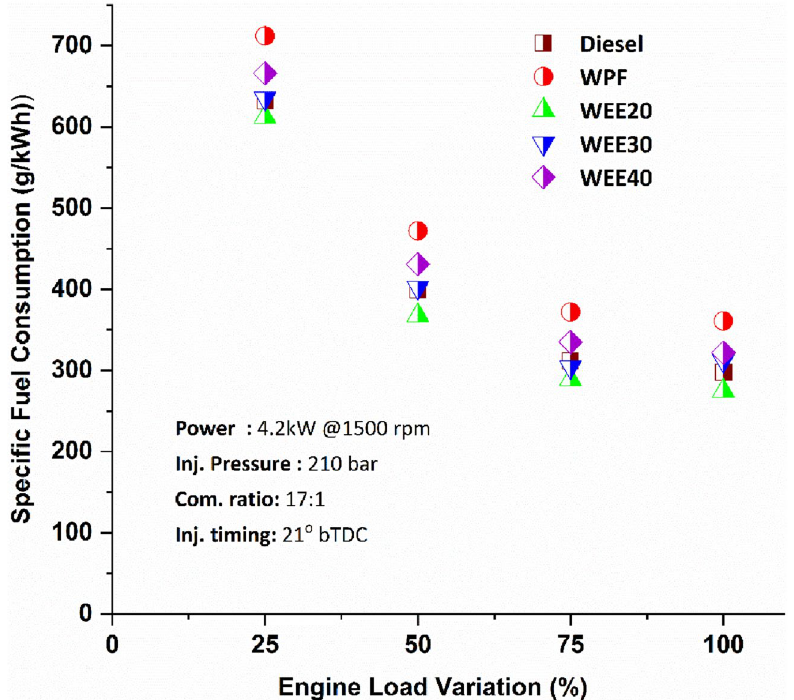
Figure 3. Performance of Specific fuel consumption on engine